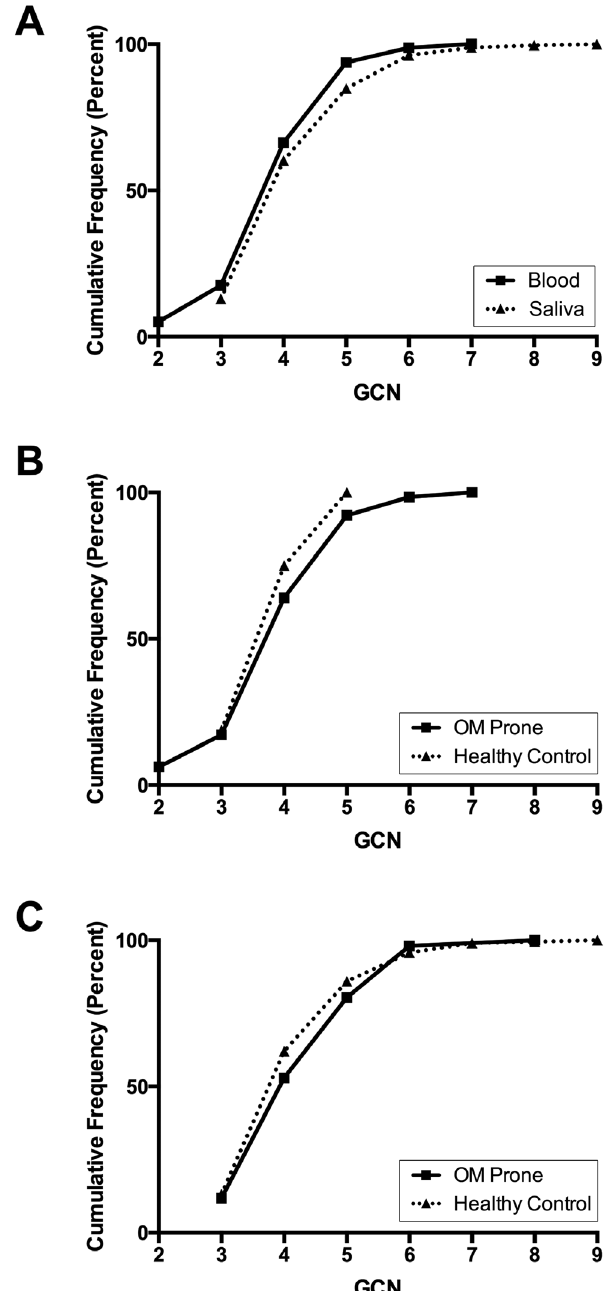
Figure 1. Cumulative frequency (percent) distribution of raw DEFB-CN determined from DNA obtained from blood and saliva samples. (Panel A) We observed a slightly lower mean DEFB-CN among gDNA templates isolated from whole blood samples (— & & —) relative to DEFB-CN estimated from gDNA extracted from saliva samples ( NNN m NNN ) ( p , 0.05, t-test). However, when stratified by sample type, there were no significant differences found between OM prone (— & & —) and control ( NNN m NNN ) DEFB-CN derived from either whole blood samples (Panel B) ( p =0.55, t-test) or saliva samples (Panel C) ( p =0.37, t-test).